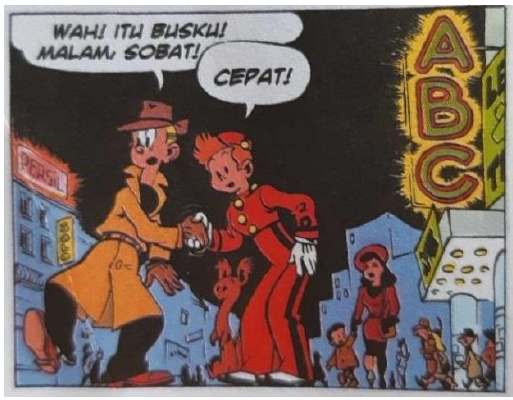
Figure 5 Fantasio et Spirou (L’équivalence